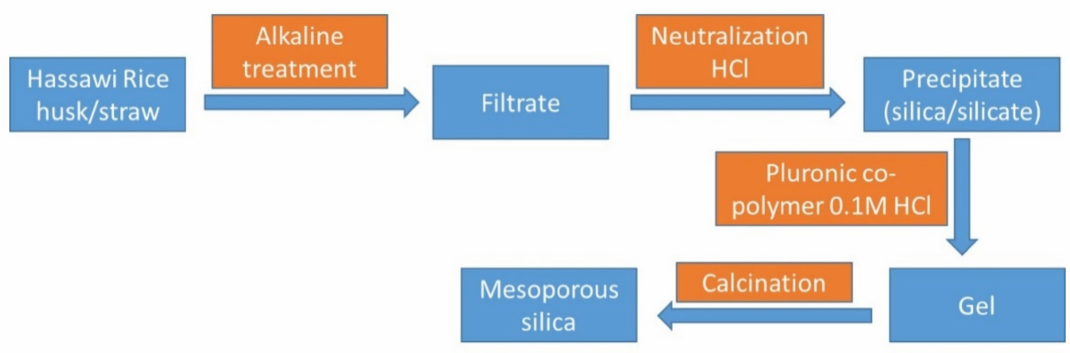
Figure 1. The valorization of Hassawi rice husk/straw into different products [17]. In the current work, the research team utilizes the bio-based silica to prepare anti-cancer compounds.